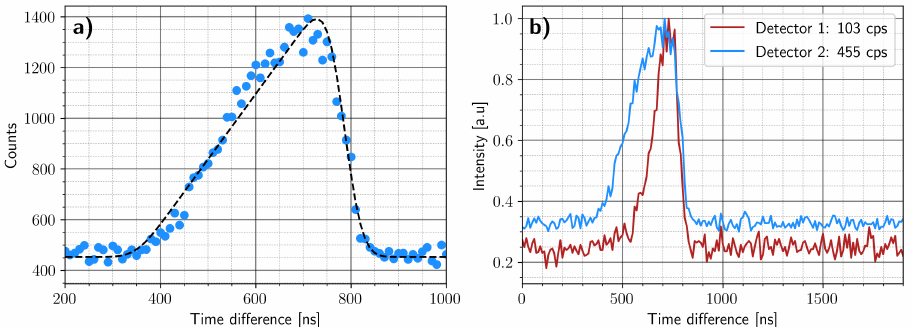
Figure 8. ( a ) Zoom in on the shape of the time coincidence histogram where an asymmetric profile is seen. The dotted black line shows a Gaussian blurred sawtooth function which would be the theoretical shape of the histogram. ( b ) The time coincidence histogram of two detectors. The sample holder is titled such that the count rate of X-rays on detector 1 is lower which is due to the shadowing of the detector. The width of the time coincidence peak is significantly lower for the shadowed detector (detector